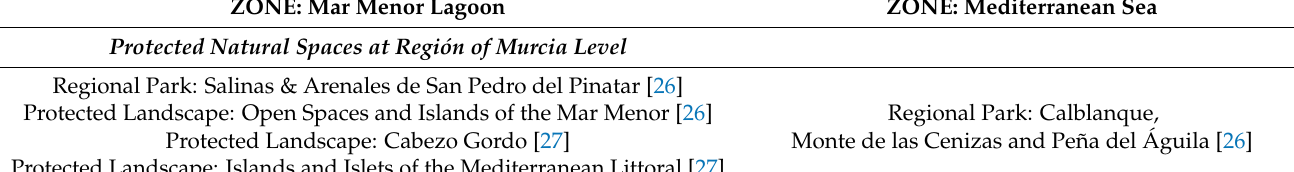
Table 1. Protected areas affected by the mining activities of the study zone. ZONE: Mar Menor